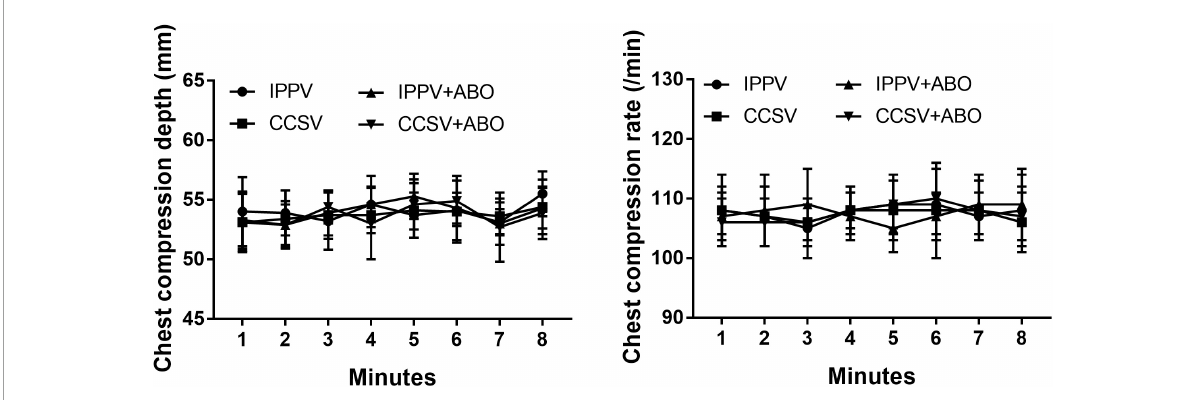
FIGURE1 The changes of chest compression depth and rate during cardiopulmonary resuscitation (CPR). IPPV, intermittent positive pressure ventilation; CCSV, chest compression synchronized ventilation; ABO, aortic balloon occlusion. Each group contained 7–10 swine during CPR.